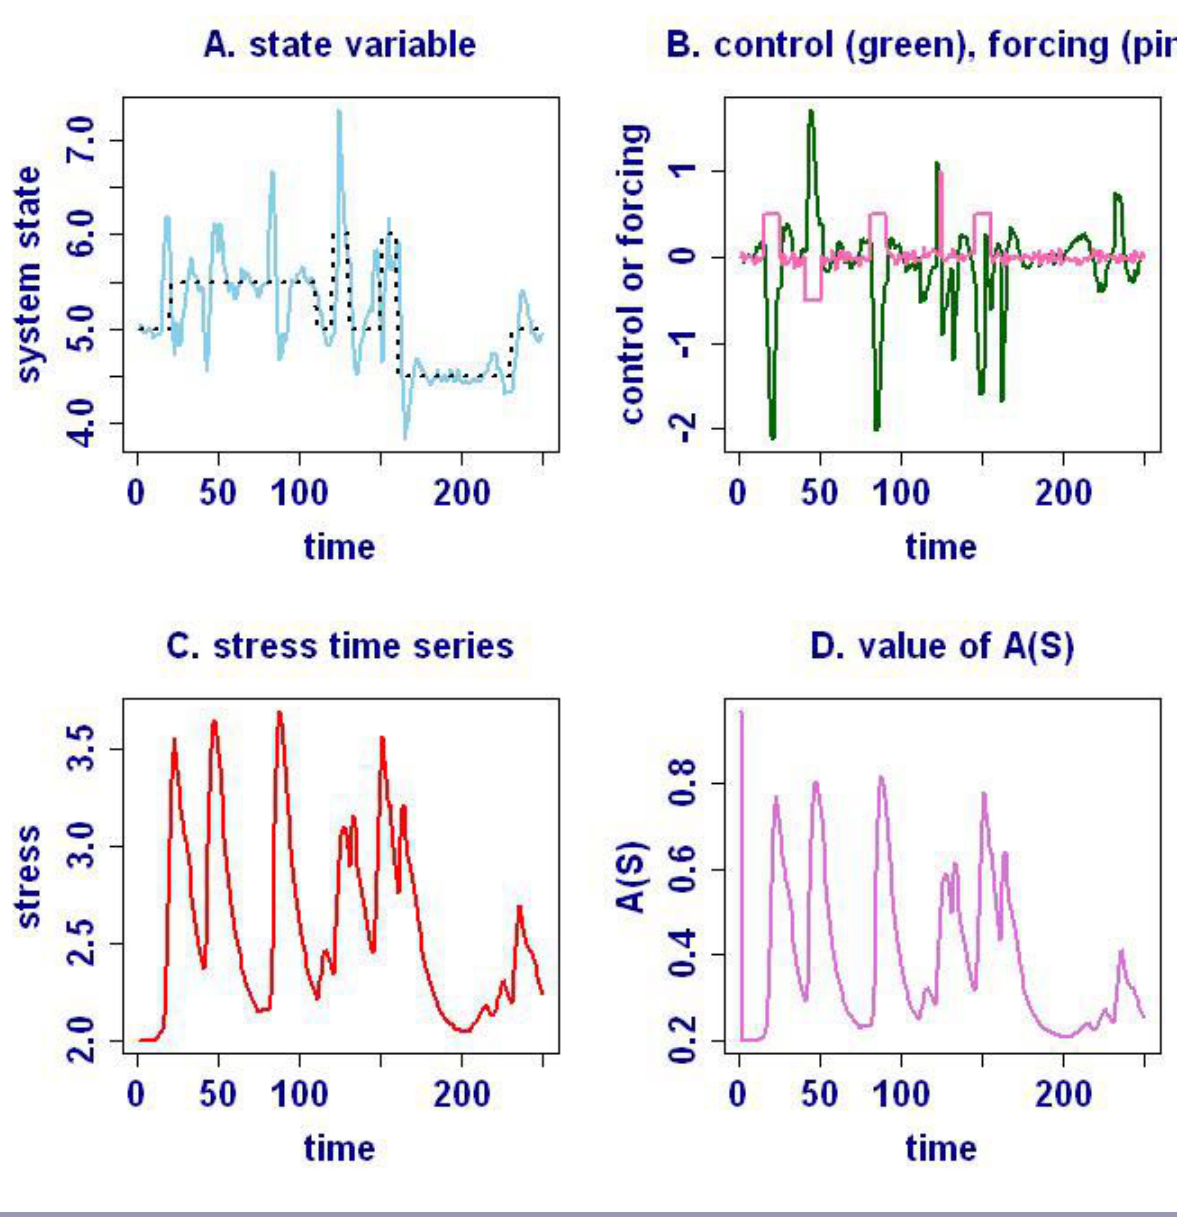
Fig. 5. Example of dynamics in the poverty trap (S* = 2). (A) State variable y (light blue) and target y* (dark blue dash). Standard deviation of the distance of y from the target is 0.38. (B) Control magnitude u and disturbance n. (C) Stress S. (D) Adaptive capacity